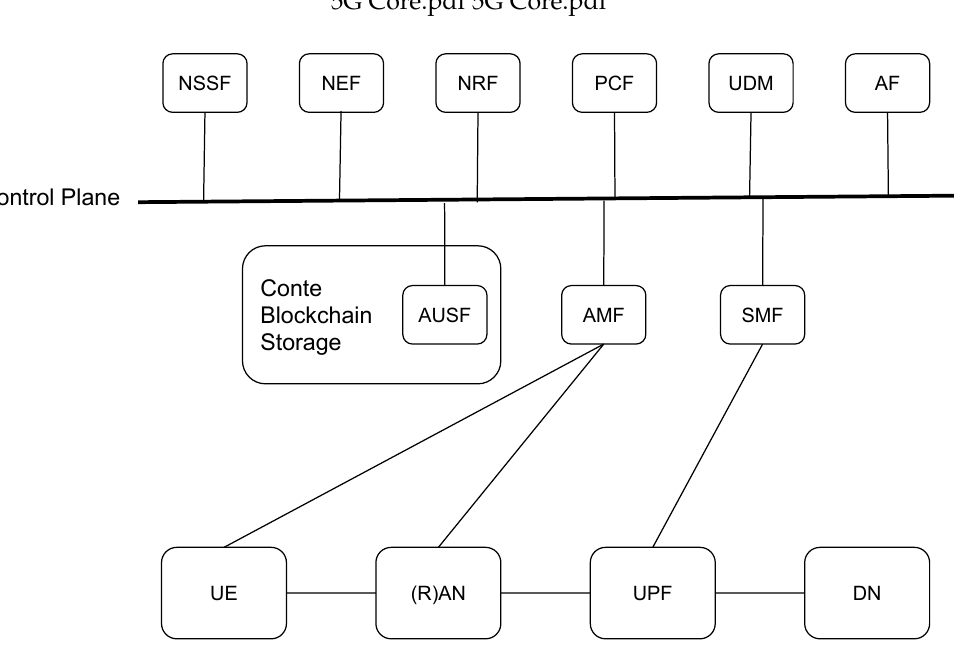
Figure 1. A logical representation of 5G network functions, with a single function (AUSF) being decentralized by using Conte blockchain